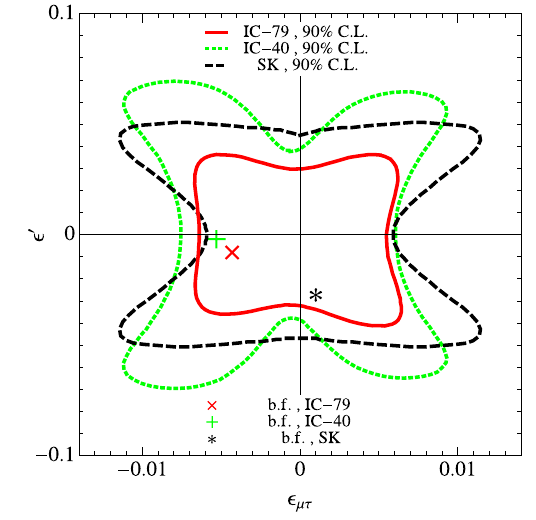
Fig. 20 Allowed region in the (cid:3) μτ ,(cid:3) (cid:19) plane at 90% CL obtained from thecombinedanalysisoflowandhighenergysamplesofdata(IceCube- 79 and DeepCore respectively), shown by red solid curve. The black dashed curve shows the allowed region from Super-Kamiokande exper- iment, taken from [130], and the green dotted curve is for IceCube-40. The red cross, green + and black star signs show the best-fit values of NSI parameters from IceCube-79, IceCube-40 and Super-Kamiokande experiments, respectively. Figure from